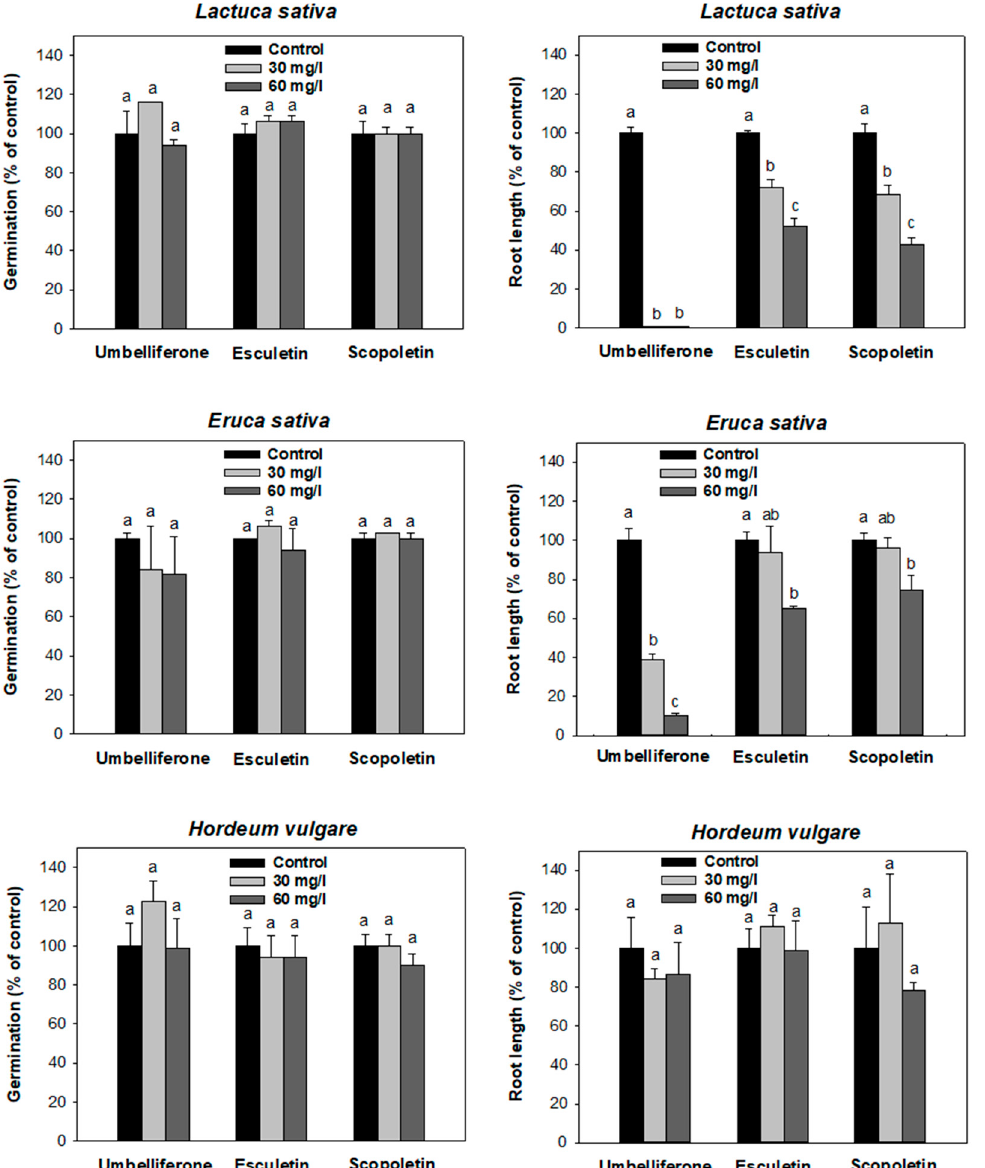
Figure 1. Effect of umbelliferone, esculetin, and scopoletin at concentrations of 30 and 60 mg/L on germination ( left ) and root growth ( right ) of L. sativa , E. sativa , and H. vulgare under Petri dish conditions (t = 6 days). Different letters above the bars indicate statistically significant differences between treatments.